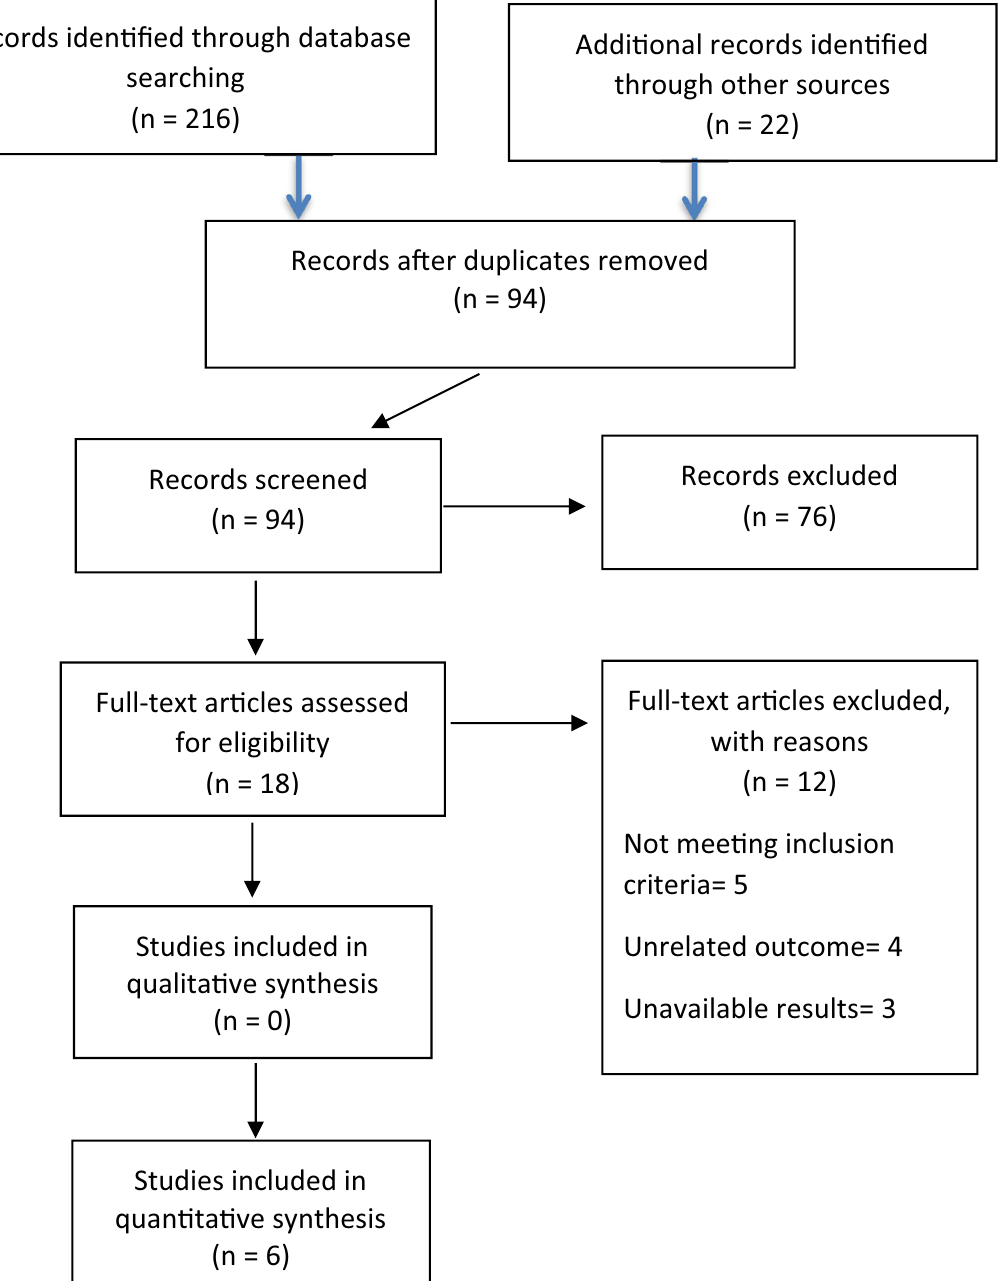
Fig. 1 PRISMA flow diagram describing the search process and the studies